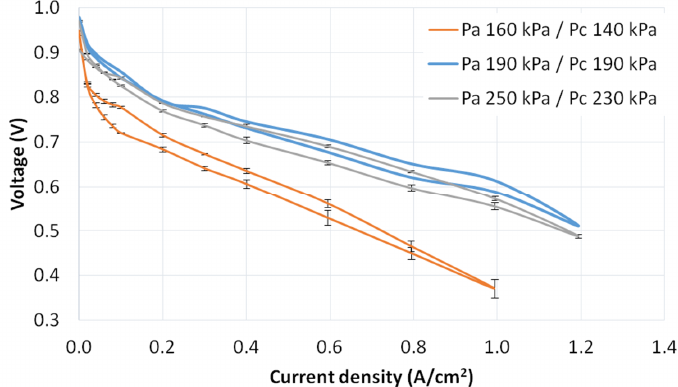
Figure 5. Polarization curve for pressure tests. Forward curve (increasing current) at the bottom; backward curve (decreasing current) at the top. Error bars corresponding to the three repetitions are included for each measurement point.